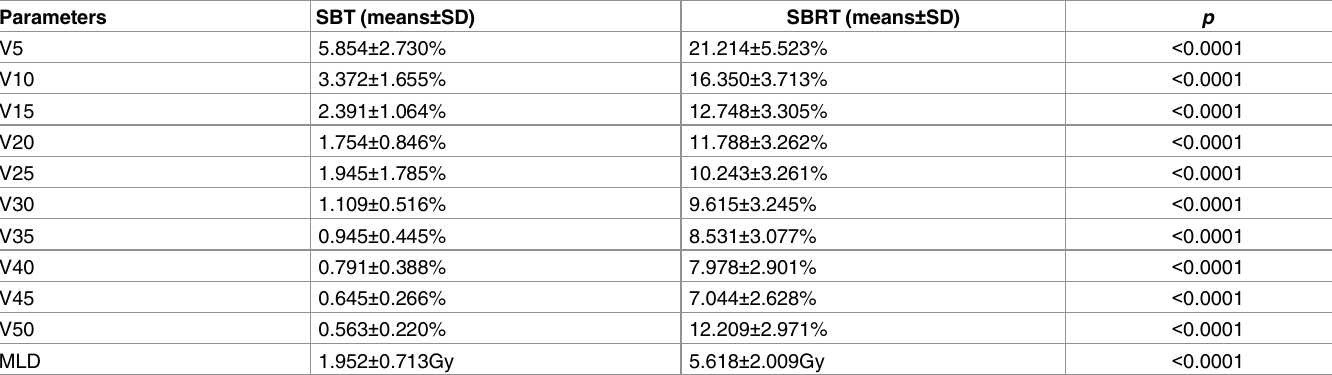
Table 3. Dosimetric comparison of the whole lung between SBT and SBRT. Parameters